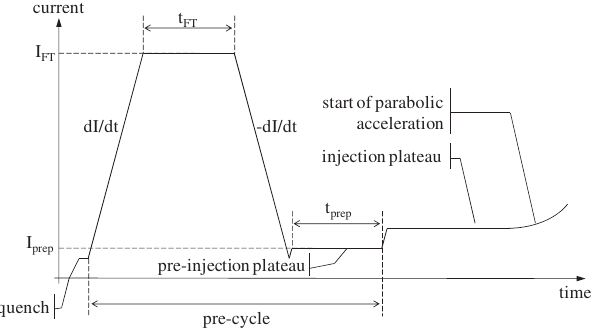
FIG. 3. Definition of the parameter affecting decay during LHC injection.